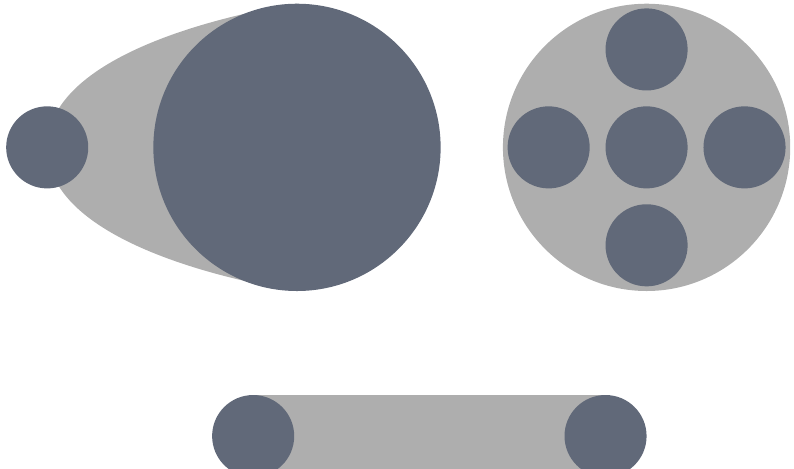
Figure 9. Sketches for isotypes to represent the various “detected patterns.” From left to right: singularity to generality. Bottom: